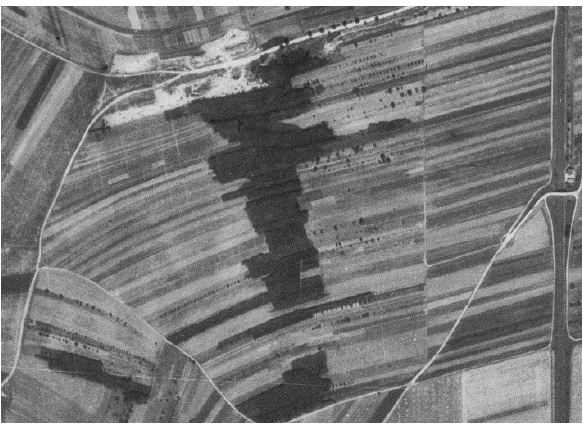
Figure 2. Original ortophotomap from